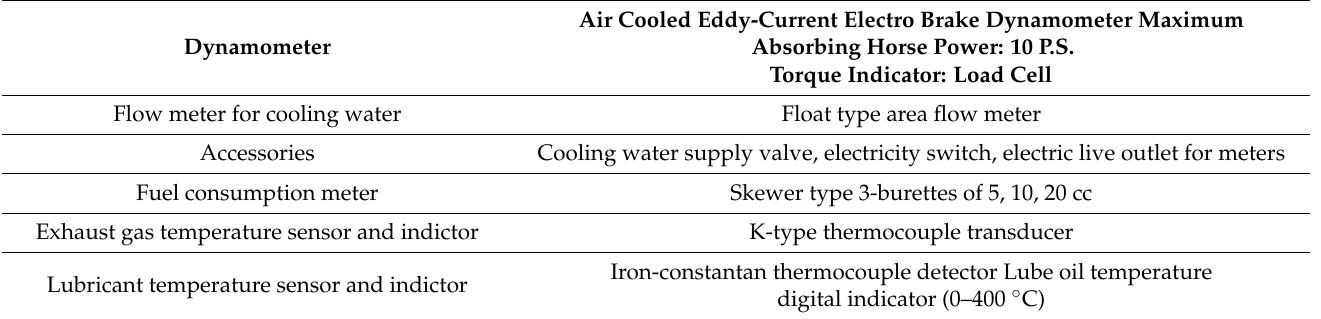
Table 4. Engine instrument